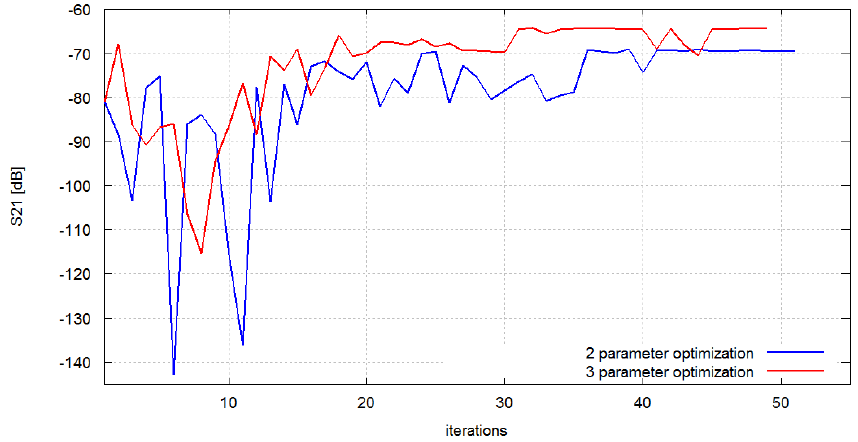
Figure 7. Optimization process for the two-antenna scenario; the objective function is S 21 .